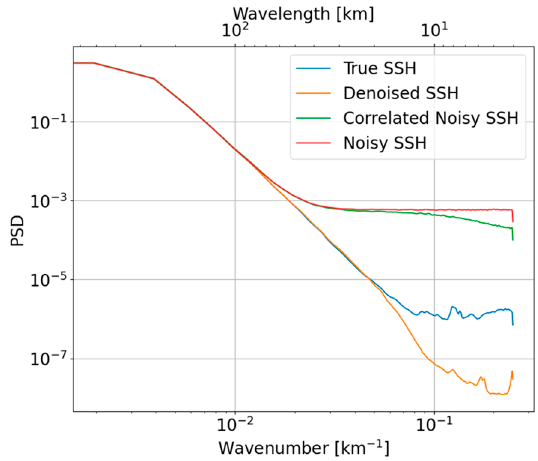
Figure 12. PSD of true SSH (in blue), noisy SSH (red), SSH with correlated noise (green) and denoising of the la tt er by U-Net (orange).